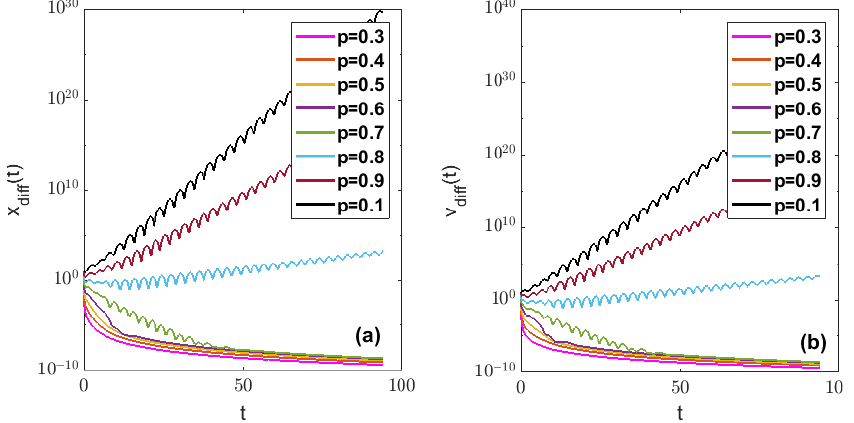
Figure 5. Average position difference function 𝑥 𝑑𝑖𝑓𝑓 (𝑡) ( a ) and average velocity difference function 𝑣 𝑑𝑖𝑓𝑓 (𝑡) ( b ) curves of time of the double-integral FOMAS (3) with different orders p (the case 𝑑 < 0 ).